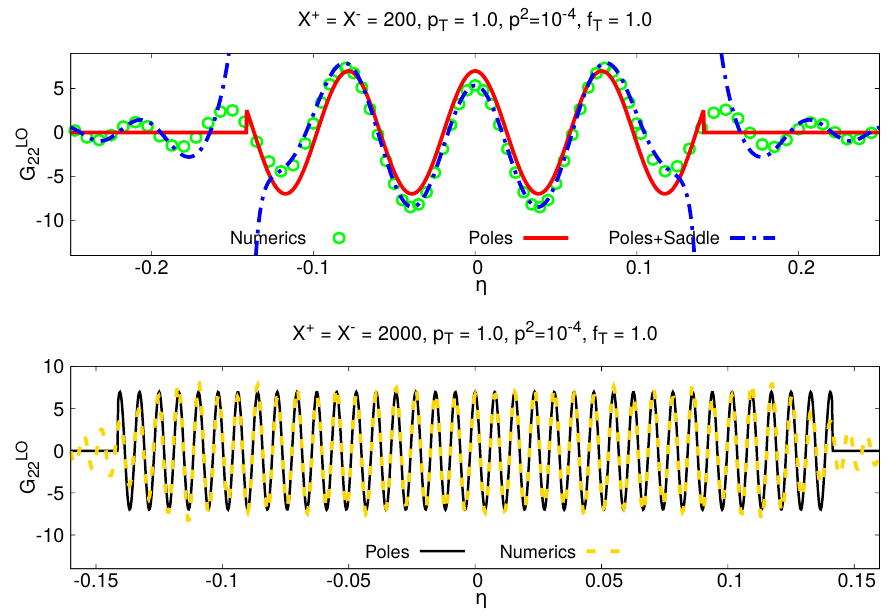
( X; p ). The top (cid:12)gure shows our 22